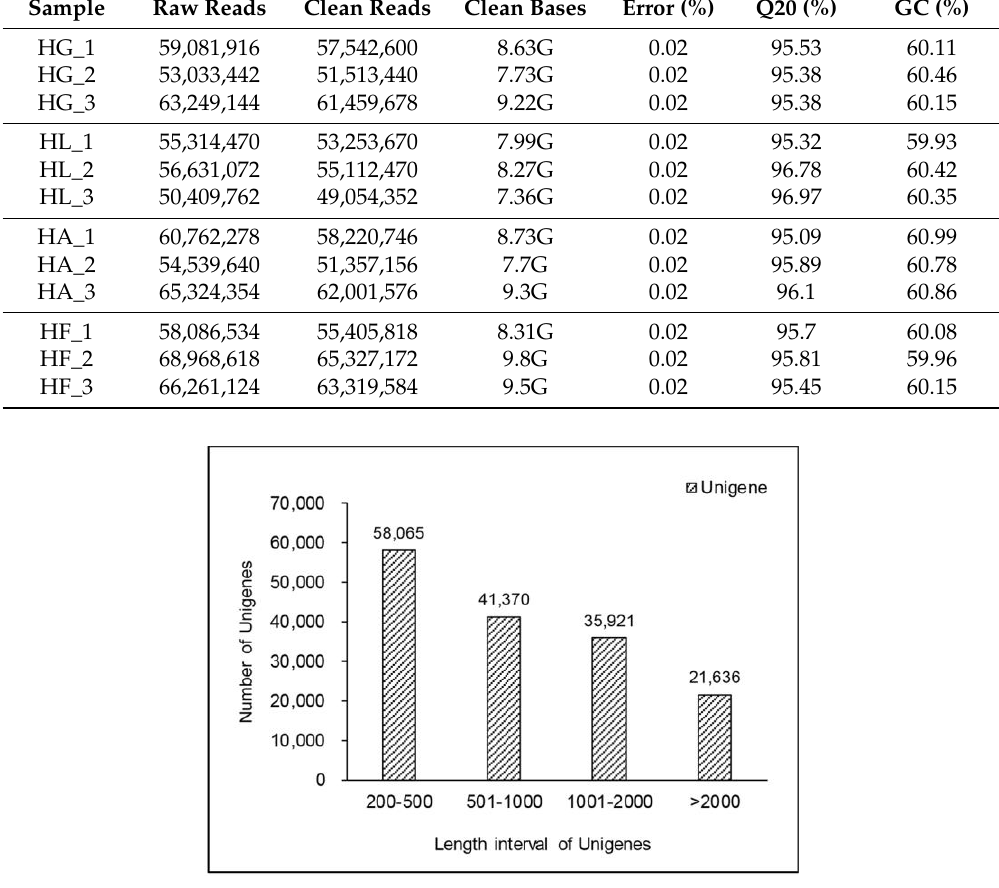
Figure 1. The length distribution of unigenes.